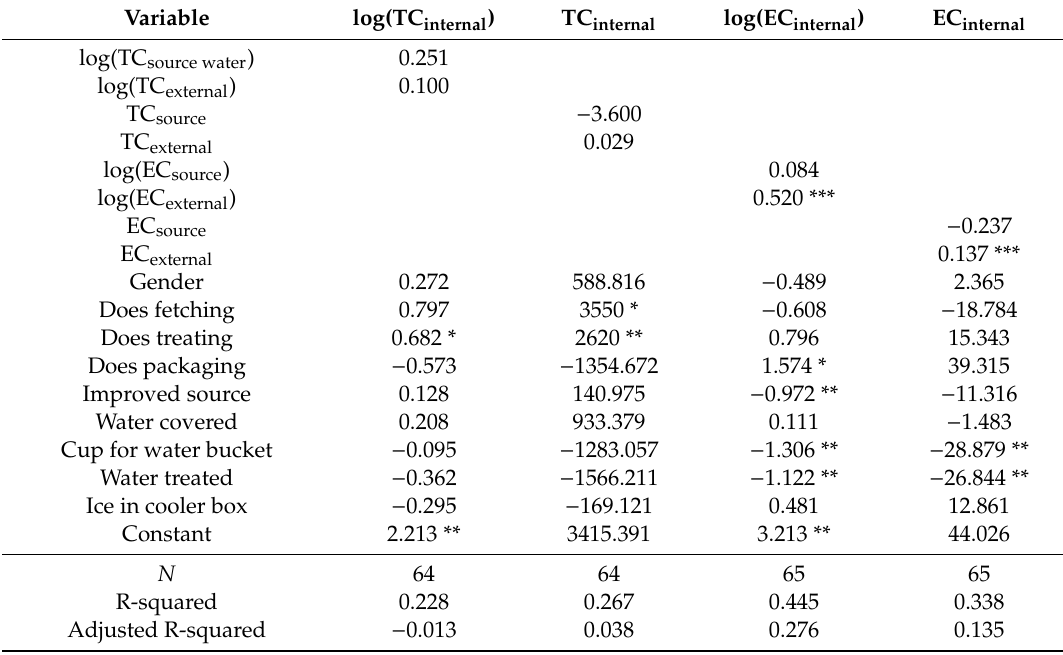
Table 5. Regression